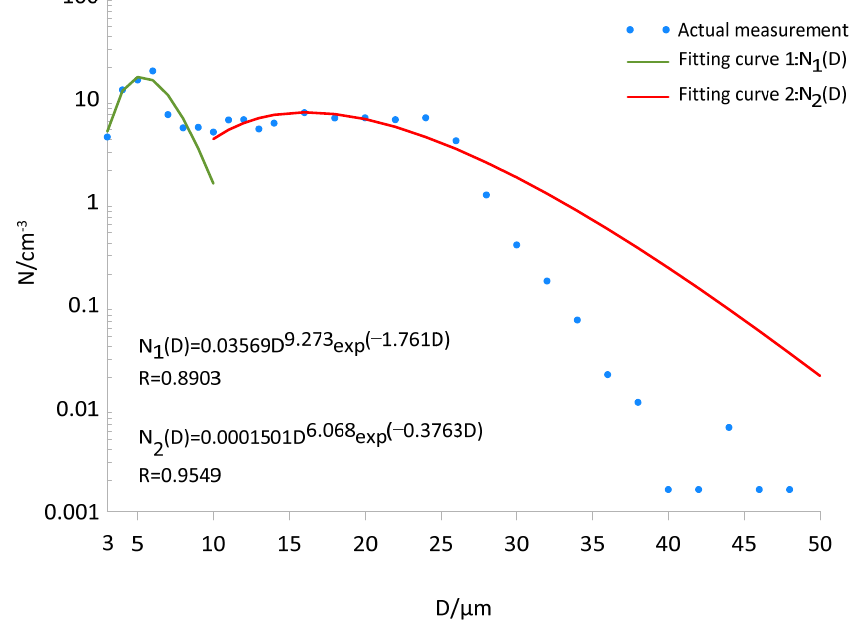
Figure 10. The average spectral distribution of sea fog process in Beilun district from 20:55 on 14 June to 7:20 on 15 June 2021.